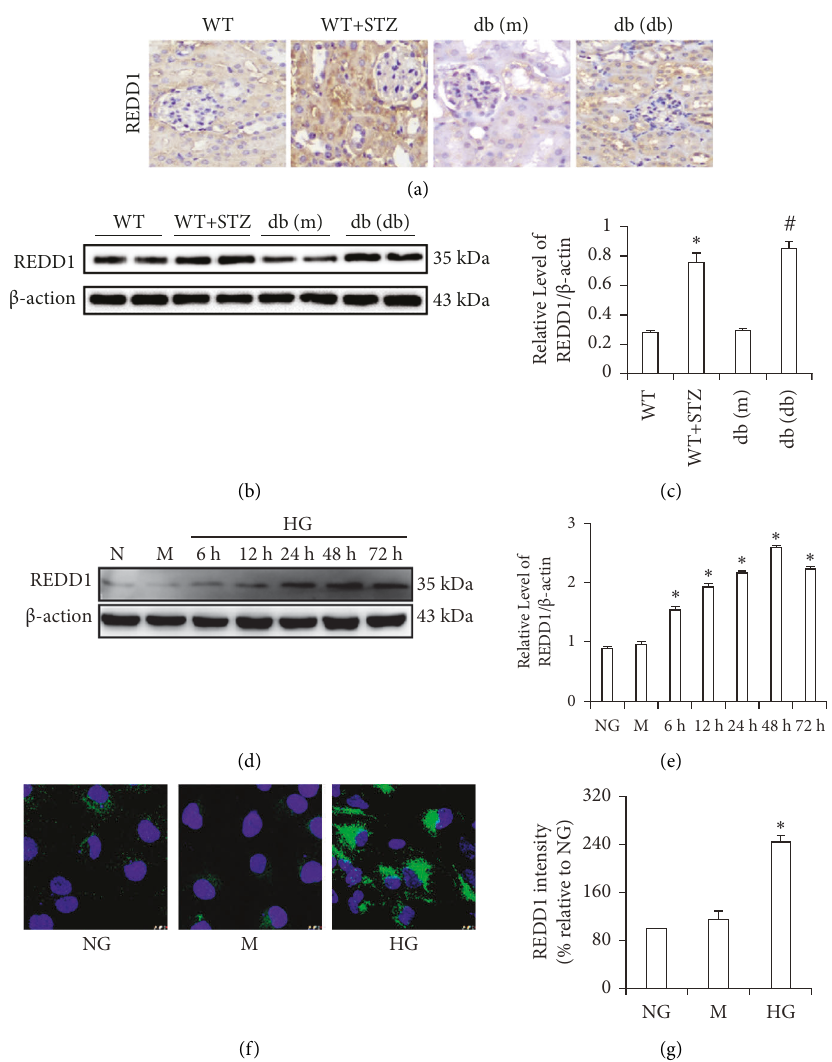
Figure 2: Expression of REDD1 in the kidneys of diabetic mice and HK-2 cells. (a) Immunohistochemical staining analysis of the expression of REDD1 in db/db mice and STZ-induced diabetic mice (scale bar, 50 μ m). (b, c) Western blot of REDD1 in the renal tissues. (d, e) Western blot of REDD1 in HK-2 cells were treated with high glucose (30mM) at varying time points. (f, g) Immunofluorescence analysis of REDD1 expression in HK-2 cells. Values are expressed as means SD ( n 5 per group). NG: normal glucose group, 5.6mM D-glucose; M: (cid:31) hypertonic control group, NG+24.4 mM mannitol; HG: high glucose group, 30 mM D-glucose. P 0 . 05 versus ± <